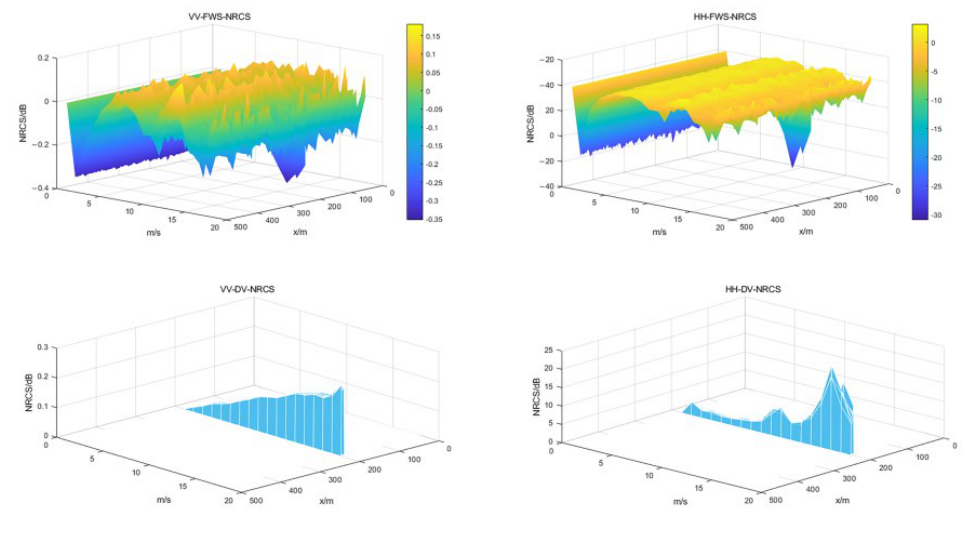
Figure 10. NRCS of freak wave surface (FWS) and the variation of the difference value (DV) of NRCS with wind speed under two polarization modes.